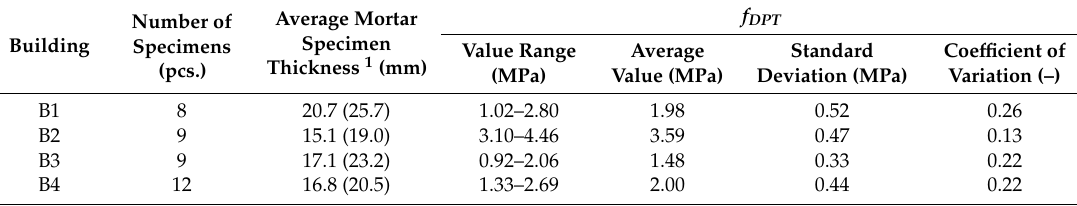
Table 3. The list of the penetrometer test results.